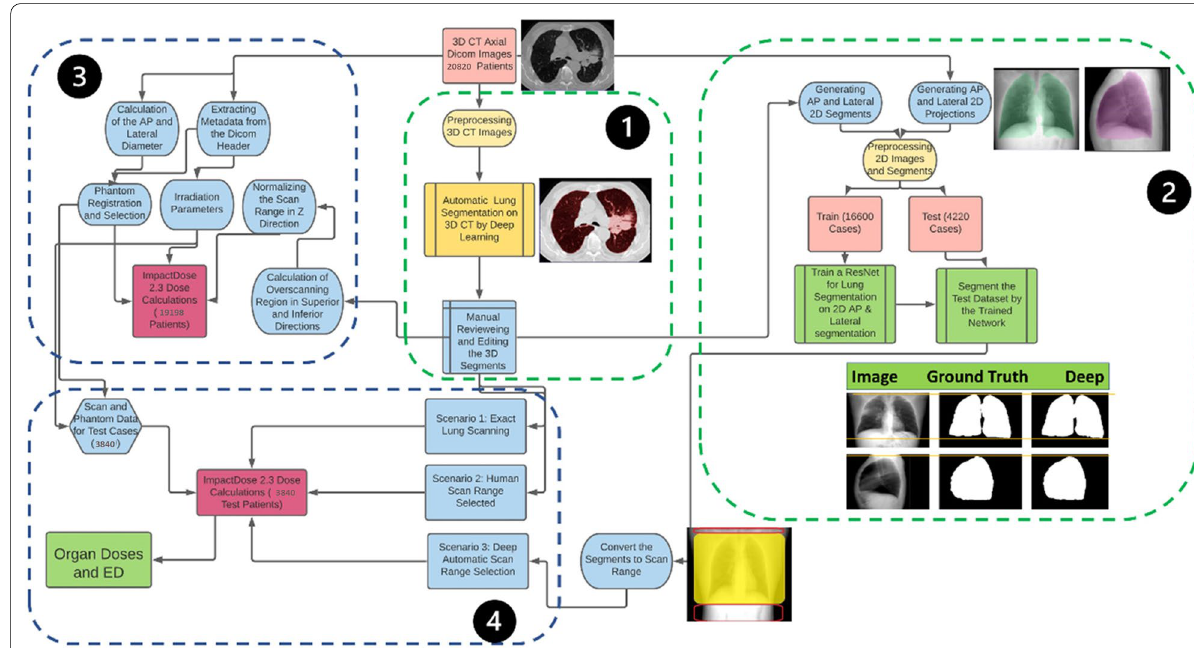
Fig. 1 The workflow adopted in this study protocol. 1) 3D lung segmentation from CT images, 2) generation of 2D projections and 2D lung segments from 3D images and training the deep learning network for semantic segmentation, 3) extracting the metadata and estimating the dosimetric impact of overscanning for all 20,820 patients. 4) Calculation of the ED and organ doses based on three scenarios described in the